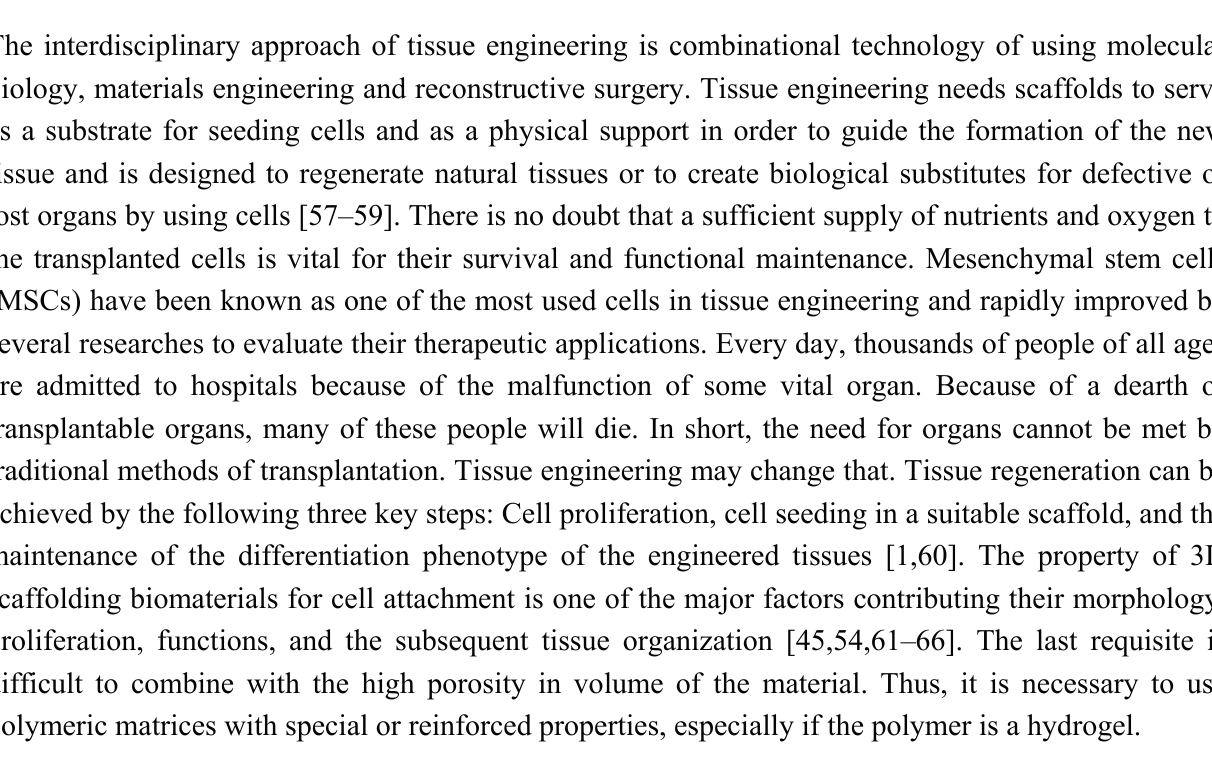
Figure 7. Schematic illustration of tissue engineering